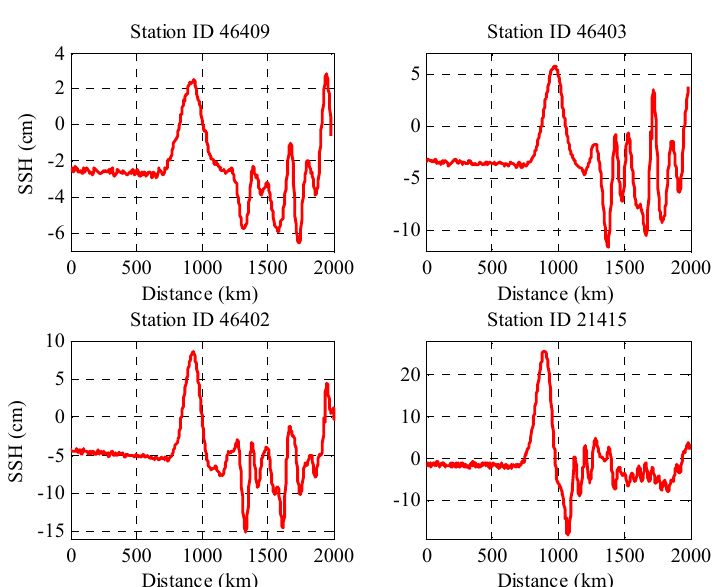
Figure 10. Tsunamis triggered by 2011 Japan earthquake and measured by buoy sensors at four observation stations.